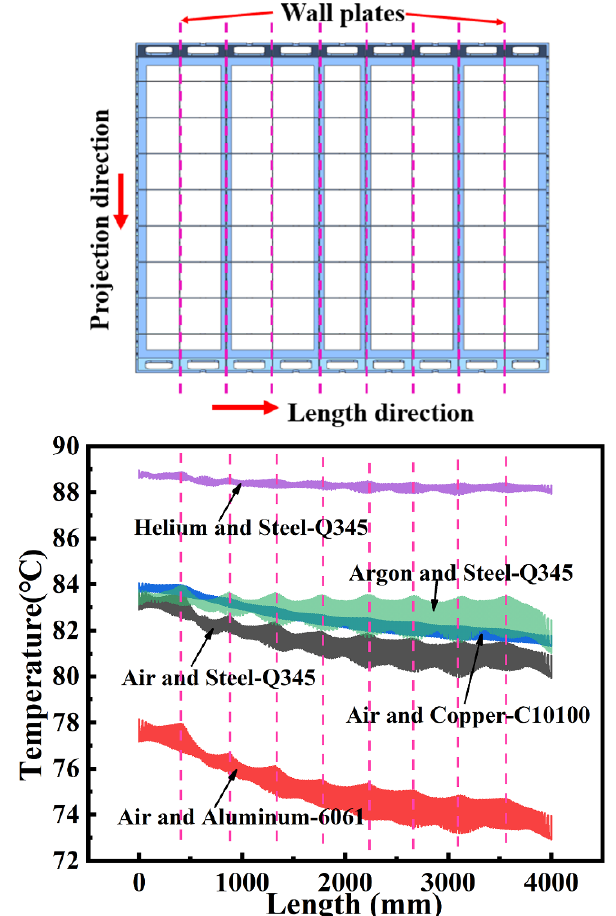
Figure 19. Temperature distribution projection and corresponding wall plates.